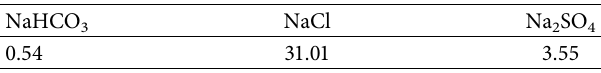
Table 6: Proportion of chemical reagents in multisalt. Unit: g/L. NaHCO 3